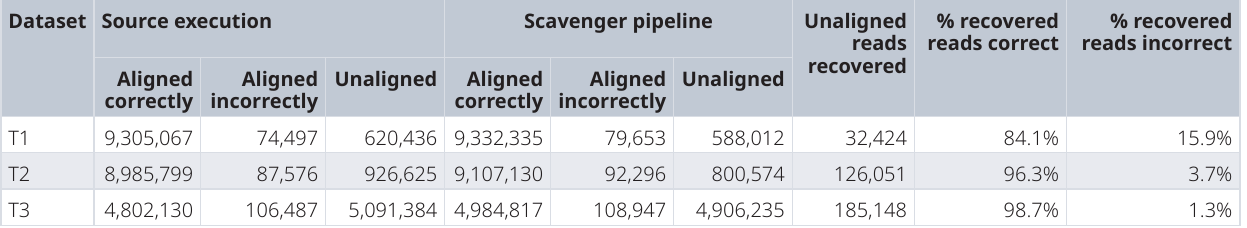
Table 7. Alignment statistics for simulated datasets before and after Scavenger recovery using default parameters for Subread. Dataset Source execution